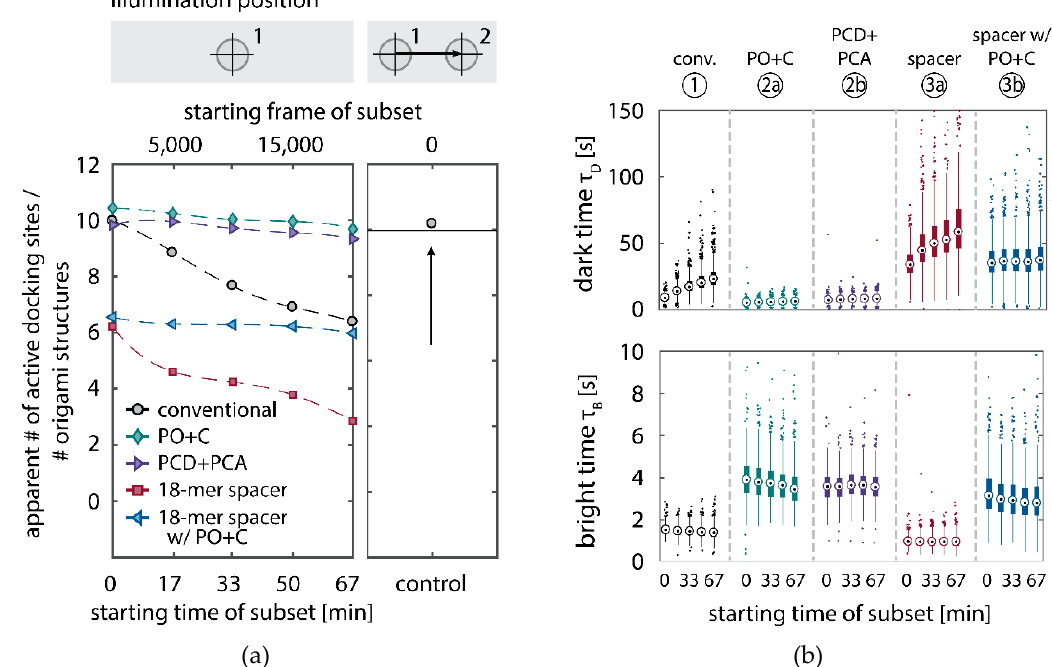
Figure 3. Quantitative analysis of the depletion of docking strands in DNA-PAINT super-resolution microscopy. The five conditions displayed are identical to Figure 2. ( a ) Left panel: active docking sites are counted individually on DNA origami nanostructures, based on the back-translation of the position of docking sites picked on automatically averaged nanostructures (Figure A4) and divided by the total number of identified origami structures. The dashed line is a guide to the eye. Right panel: a control of 5,000 frames, equivalent to the first subset, was measured in a previously not irradiated area on the same sample and compared to the initial number of active docking sites (solid horizontal line) for the conventional condition (right panel). The total numbers of identified DNA origami nanostructures for the five conditions are: (1) 786, (2a) 824, (2b) 566, (3a) 690, (3b) 580 and 690 for the control of condition (1). ( b ) Box plots of the bright times τ B and dark times τ D for the subsets shown in (a). Circles indicate the median; bottom and top edges of the box (bold vertical lines) indicate the 25th and 75th percentiles, respectively. The whiskers extend to the data points not considered outliers (thin vertical lines); outliers are plotted individually as dots.